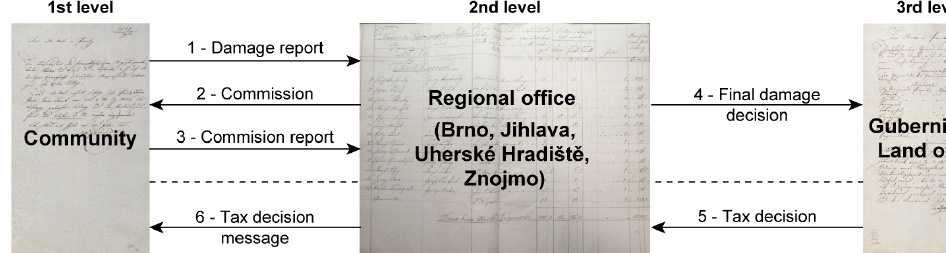
Figure 2. Standard procedure for tax remission and/or rebate.